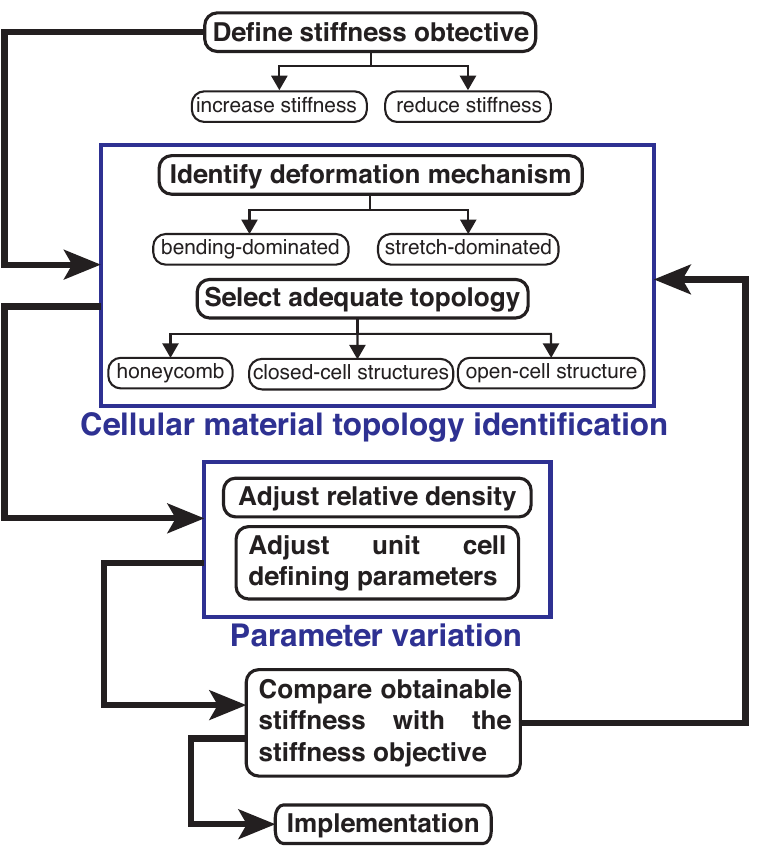
Figure 7. Guideline diagram to select an appropriate cellular material for tailoring